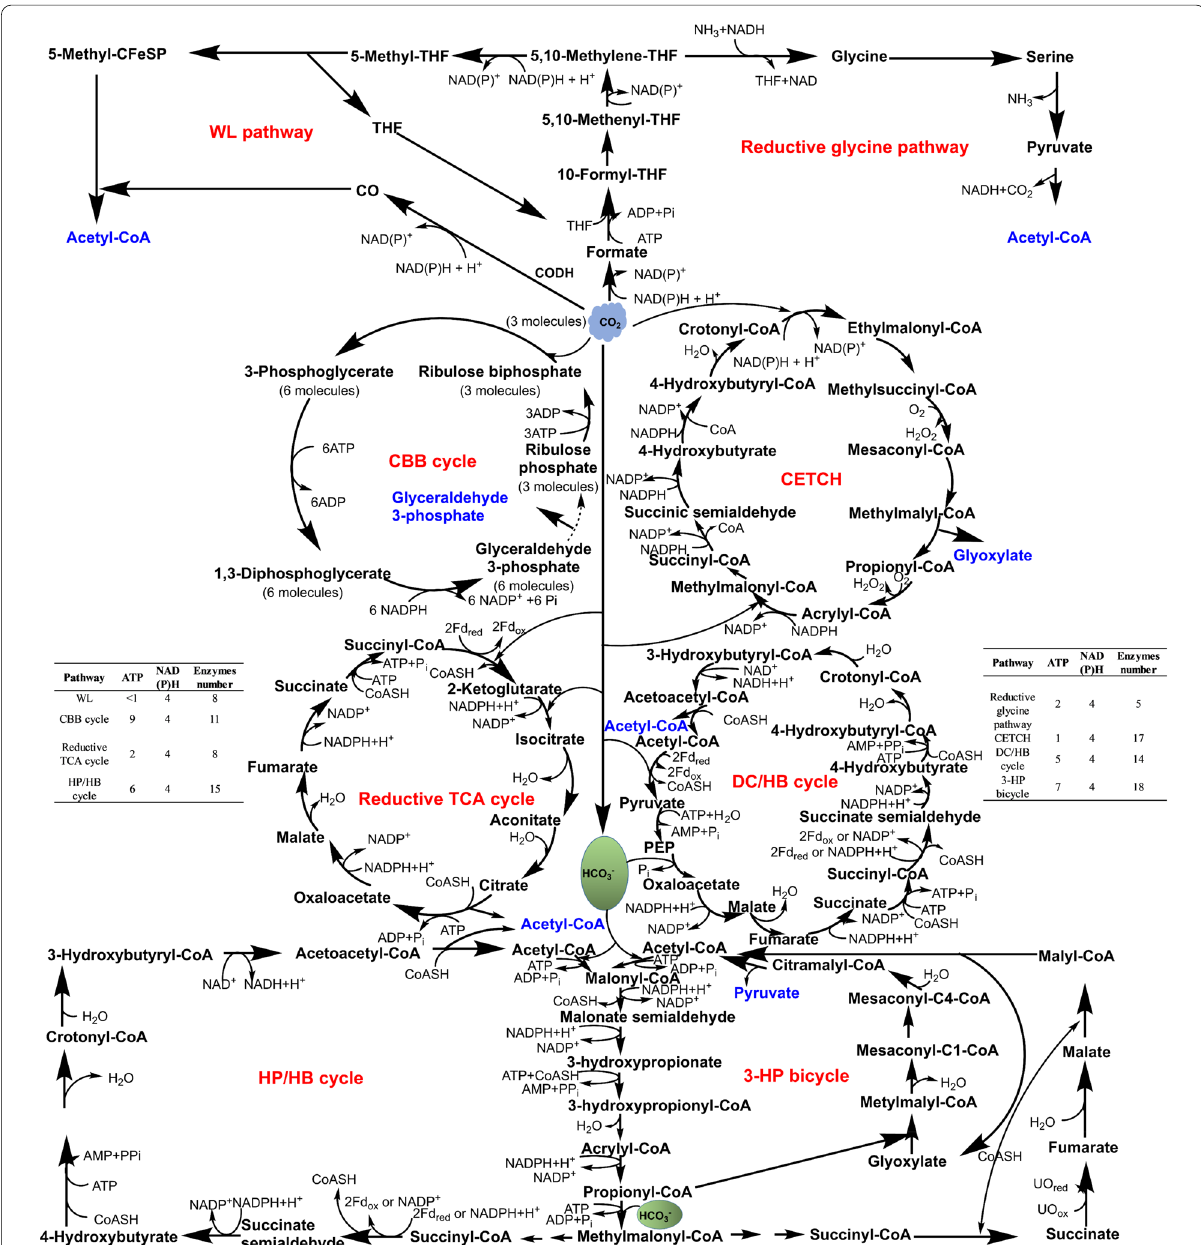
Fig. 3 Common fixed pathway of CO 2 . The number of enzymes, the amount of ATP consumed and the reduction equivalent are given, and the metabolic spillover products of each pathway are represented in blue